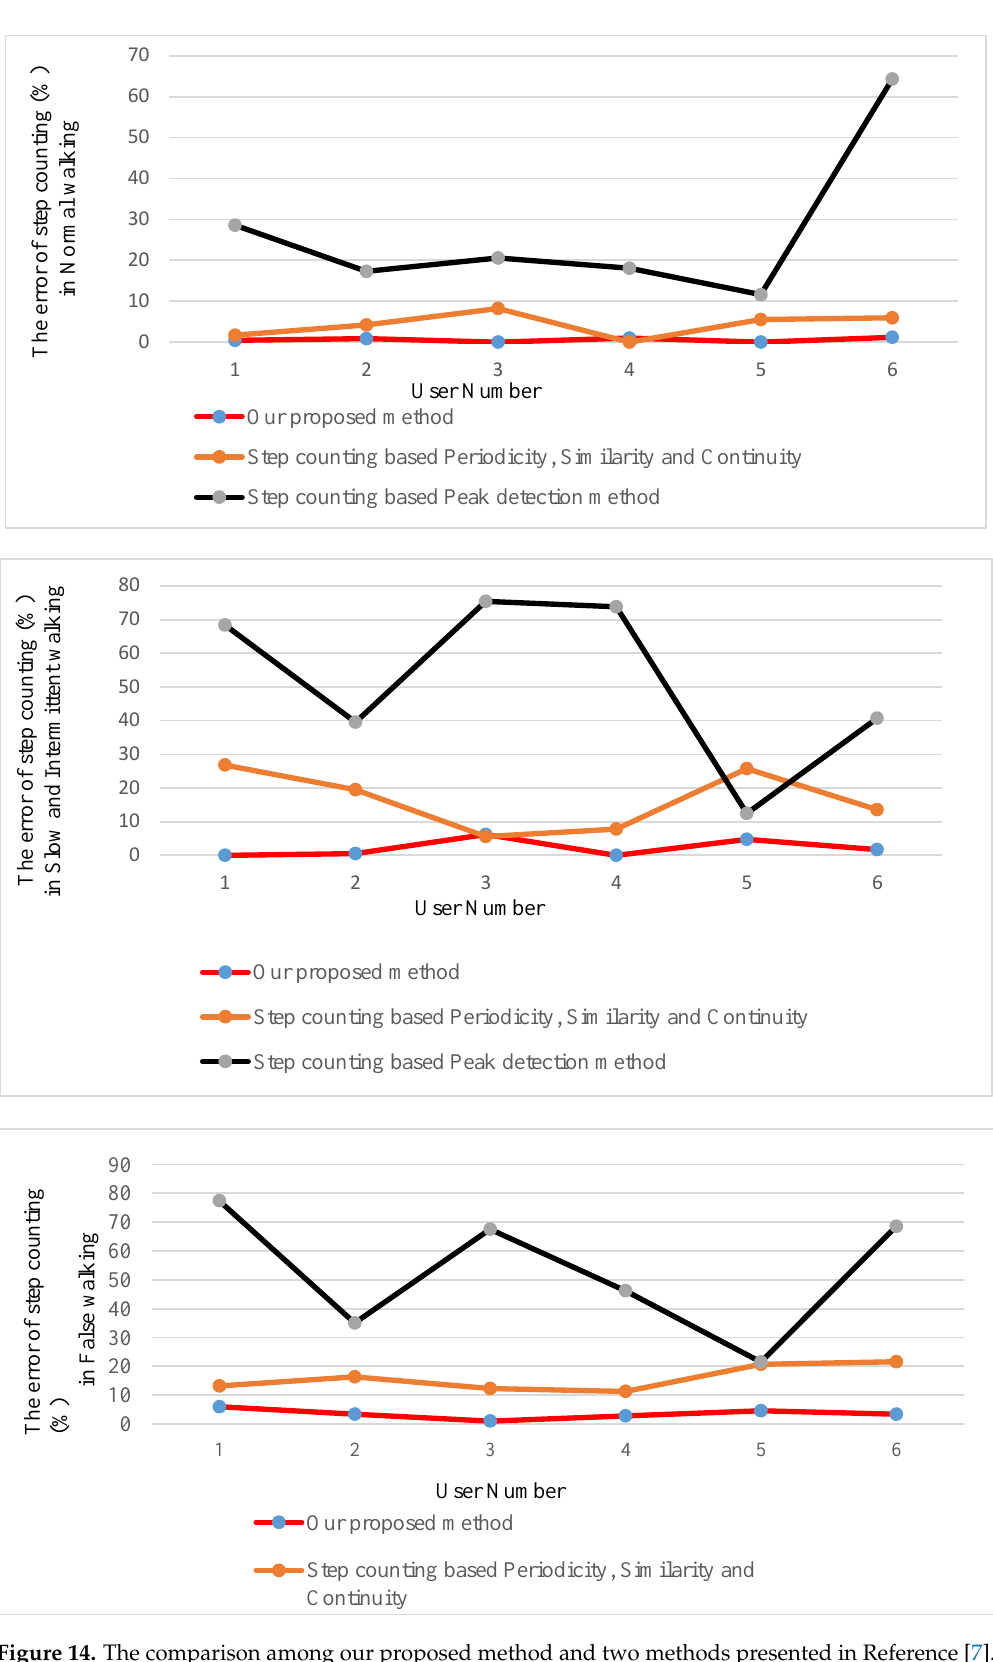
Figure 14. The comparison among our proposed method and two methods presented in Reference [7].